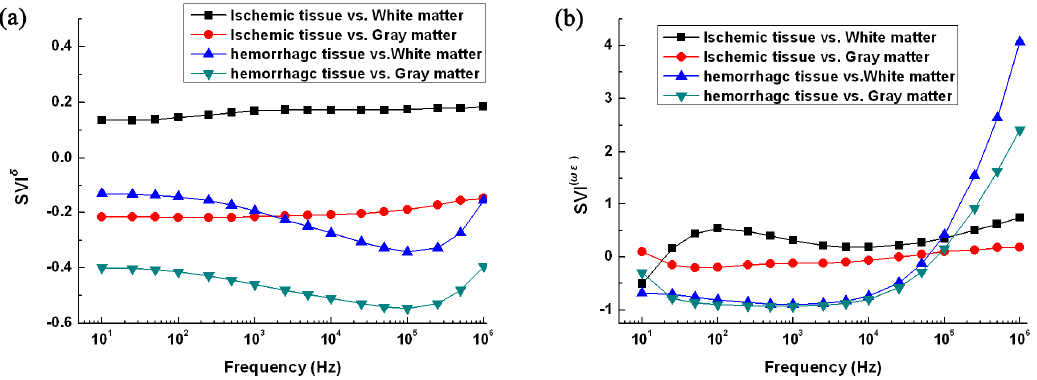
Figure 5. Difference in conductivity ( a ) and permittivity ( b ) between normal brain tissue and stroke lesions at each frequency within 1 MHz. A vs. B (A and B are two kinds of tissues) represents the relative difference between A and B, namely, SVI = (A − B)/B.